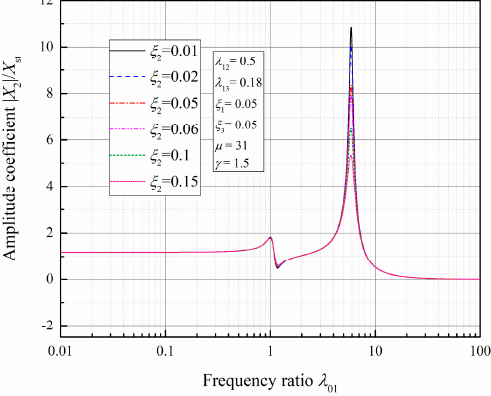
Figure 14. The dynamic response of the accessory structure upon varying the parameter ξ 2